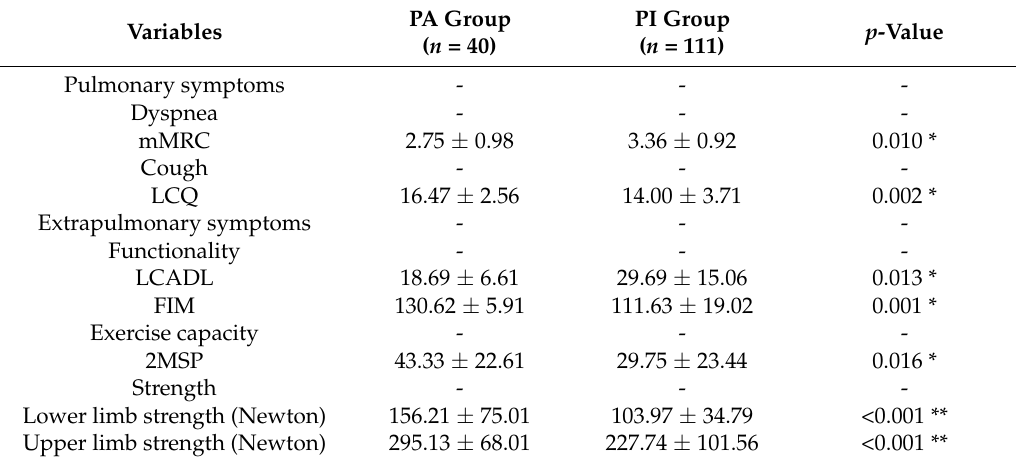
Table 2. Differences in symptomatology, functionality, exercise capacity and strength per